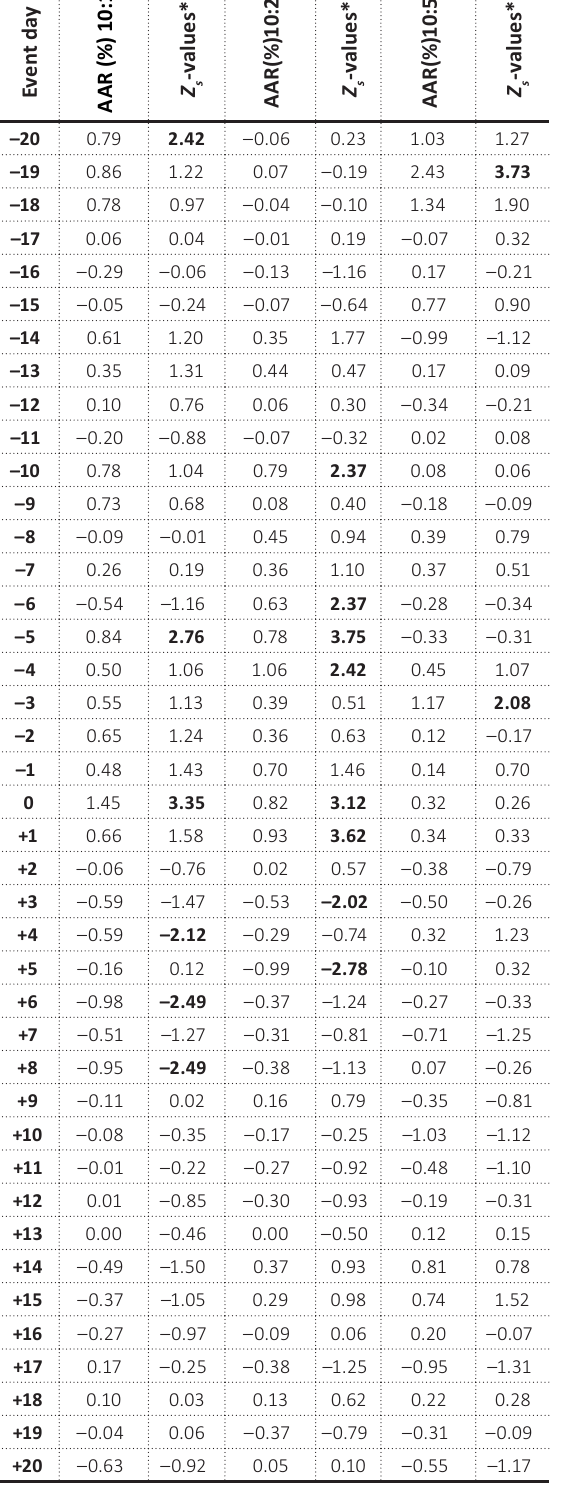
-values – Announcement s